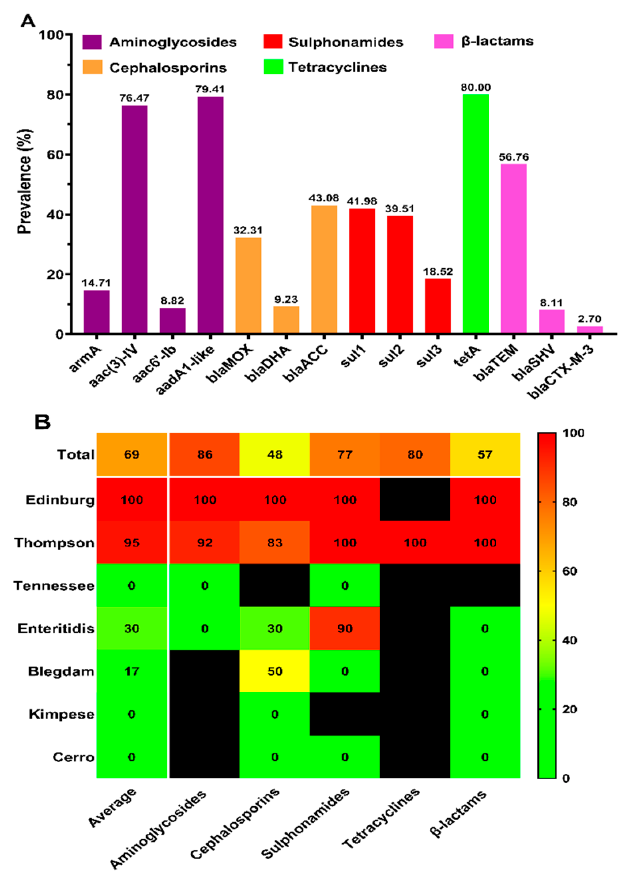
Figure 4. Phenotype-genotype concordance of antimicrobial resistance. ( A ) Prevalence of genotypic drug-resistance among Salmonella isolates possessing corresponding phenotypic drug-resistance. Resistant genes belonging to the same class of resistant phenotypes are shown in the same color; ( B ) serovar distribution of concordance between genotypic and phenotypic drug resistance. Each column represents a resistance category, except the first column, which averages the concordance between the genotype and phenotype of the five categories. Due to the small sample size of S. Entebbe, S. Tamilnadu, S. Fillmore, and S. Gatuni, each serovar had only one strain, so we only analyzed the remaining seven serovars with relatively large sample sizes. The color of the individual cells varies with the percentage of phenotype–genotype concordance shown in the cells. Cells represented by black mean that the corresponding serovar was phenotypically susceptible and was not tested for the presence of the corresponding resistance genes; thus, the concordance percentage was not